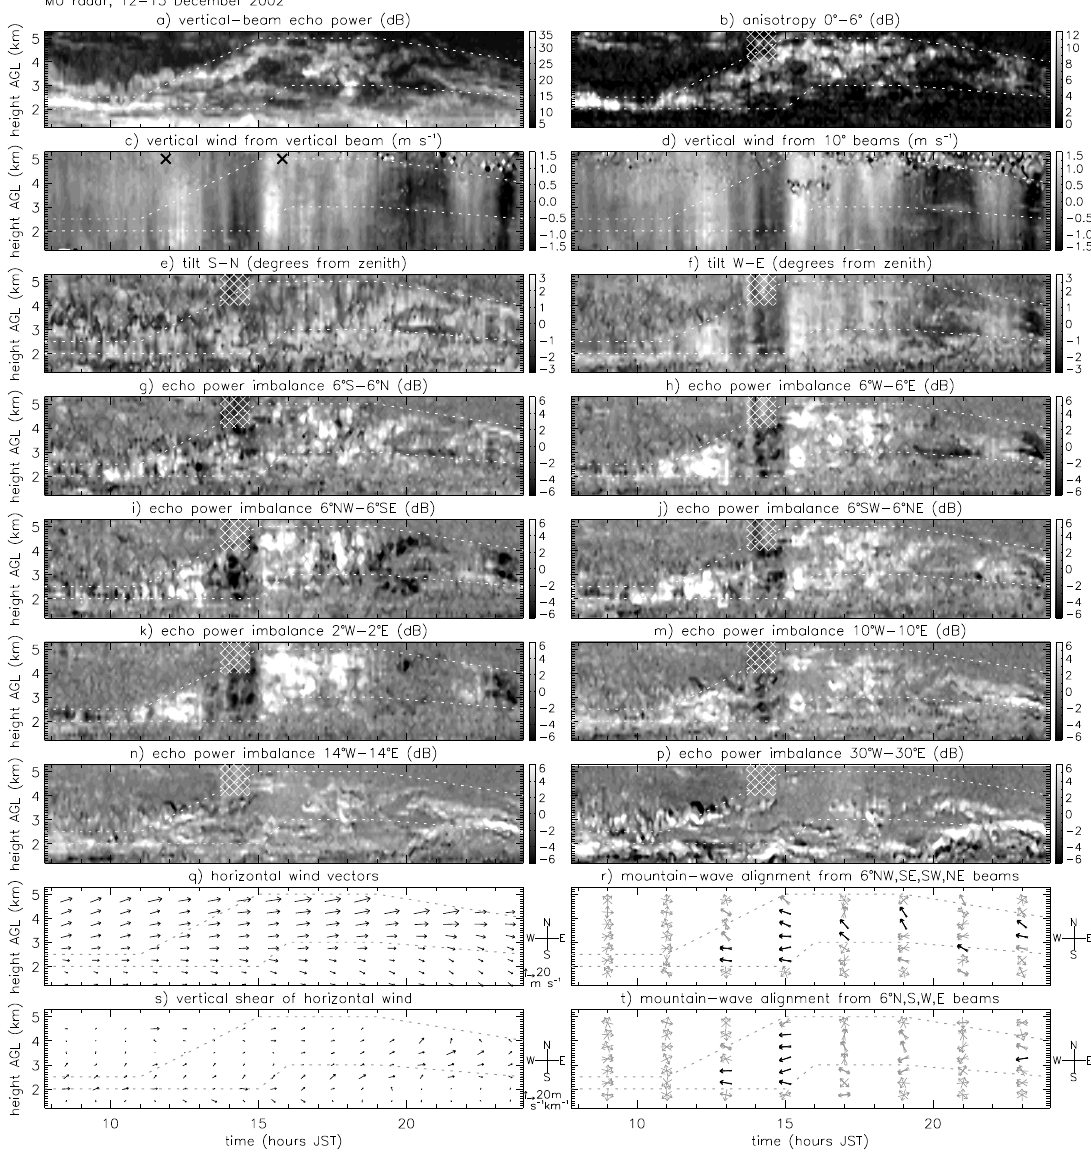
Fig. 2. Height-time plots of ( a ) vertical-beam echo power; ( b ) anisotropy, vertical minus mean 6 ◦ echo power; ( c, d ) vertical wind measured by vertical and symmetric 10 ◦ beams, × shows times of radiosondes in Figs. 3a and b; (e, f) tilt of aspect-sensitive echo power from zenith, with positive tilt defined as to (e) south and (f) west; ( g–p ) echo power imbalances (EPI) between symmetric pairs of radar beams at 2 ◦ , 6 ◦ , 10 ◦ , 14 ◦ , 30 ◦ zenith, the hatched pattern in Figs. 2b, e–p covers radio-frequency interference; (q, s) vectors of (q) horizontal wind and (s) vertical shear of horizontal wind; ( r,t ) alignment of horizontal wavevector of mountain waves, using EPI from (i, j) and (g, h), black arrows showing | W | > 0.2ms − 1 and azimuth error < 12 ◦ . Identical dotted lines in (a) − (t) show the approximate region of aspect sensitivity in (b), which is the most relevant area in